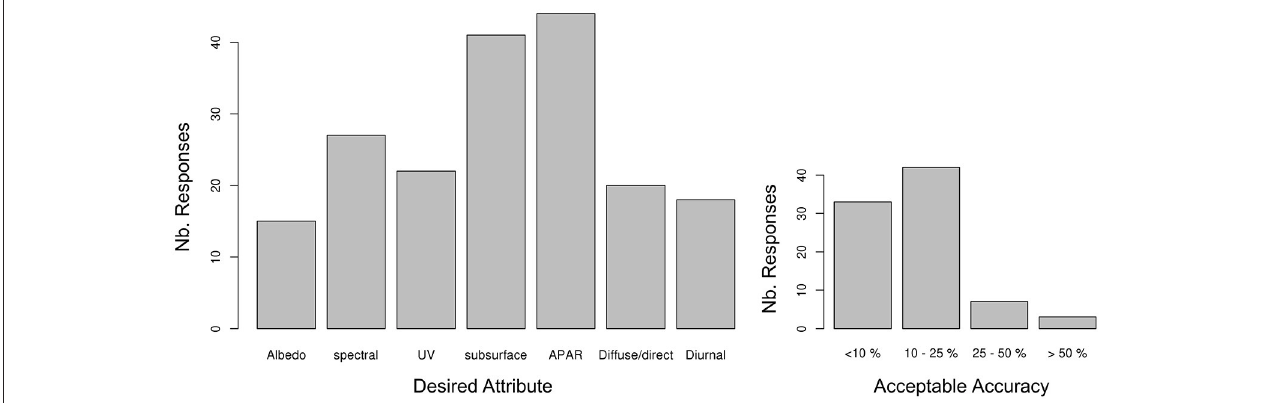
FIGURE 8 | Results of PML user requirement questionnaire for satellite-derived PAR (Left) . Histogram of desired products and attributes (Right) . Histogram of acceptable uncertainty for PAR. (Based on data from 63